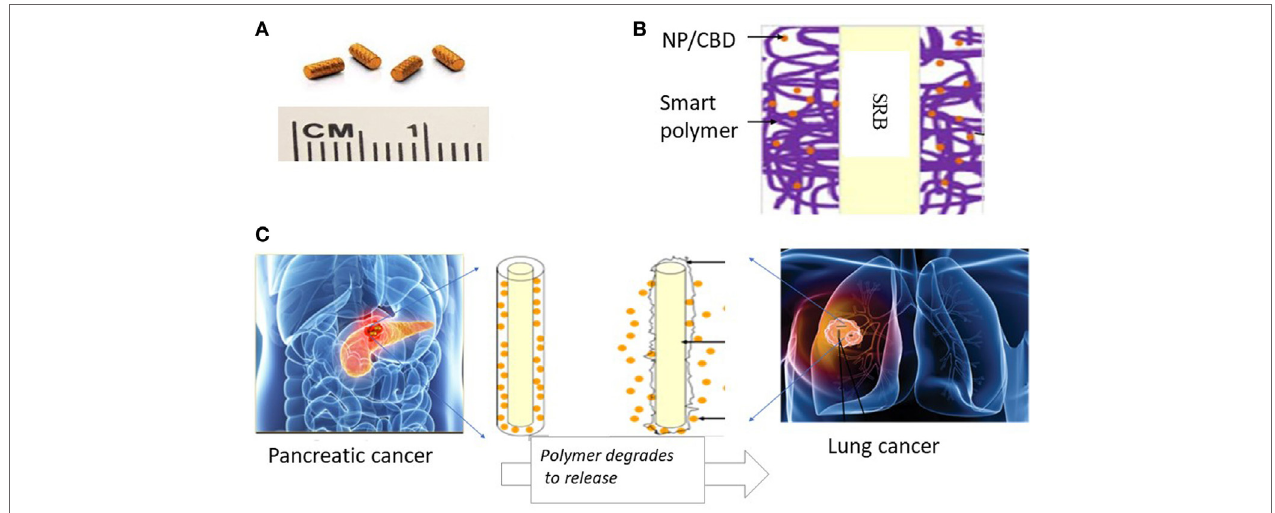
FigUre 5 | Illustration of innovative approach with potential to significantly enhance therapeutic efficacy using cannabinoids (CBDs). (a) Currently used commercially available inert radiotherapy (RT) biomaterials, e.g., fiducials (CIVCO Medical); (B) one design of multifunctional biomaterial [smart biomaterial (SRB)] made of Food and Drug Administration-approved biocompatible biodegradable polymer loaded with a payload of CBDs; (c) potential clinical translation pathway is envisioned where the smart SRB could simply replace the inert biomaterials currently used for image-guided RT. Such replacement would come at no additional inconvenience to cancer patients. Once in place the SRB can be activated to sustainably release its payload as the polymer coating degrades for greater effective tumor cell kill working in synergy with RT as highlighted by our study